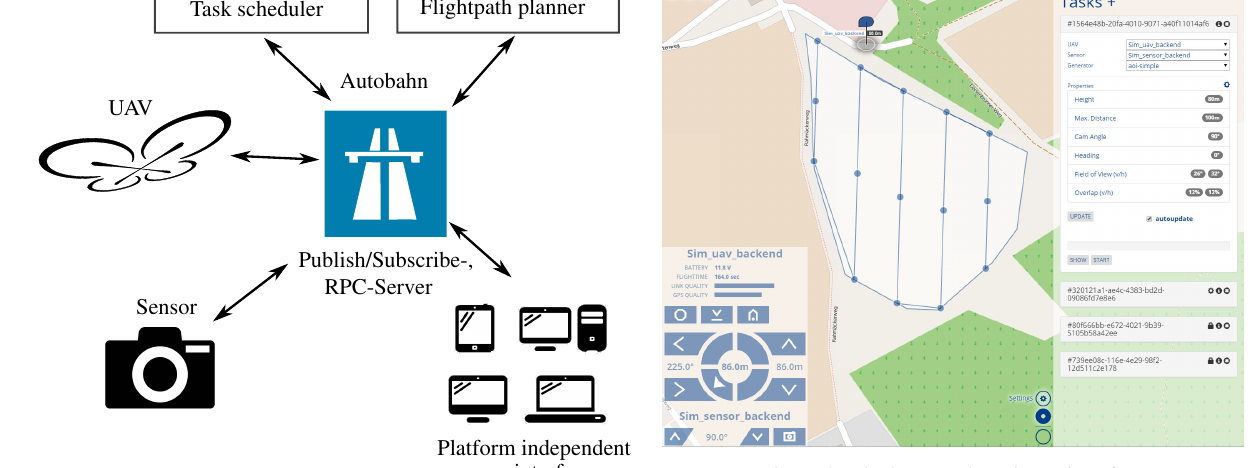
Figure 2: The browser based user interface